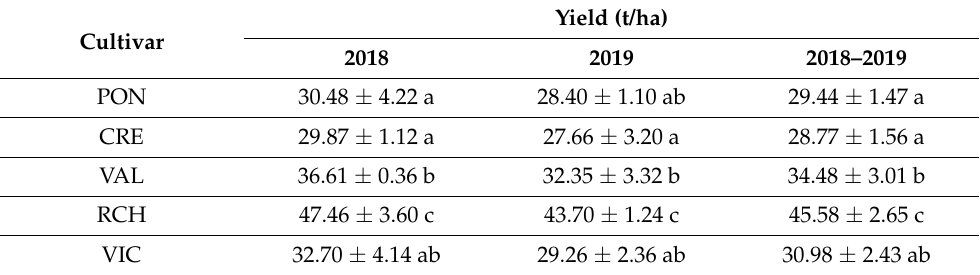
Table 5. The yields of rhubarb petioles.